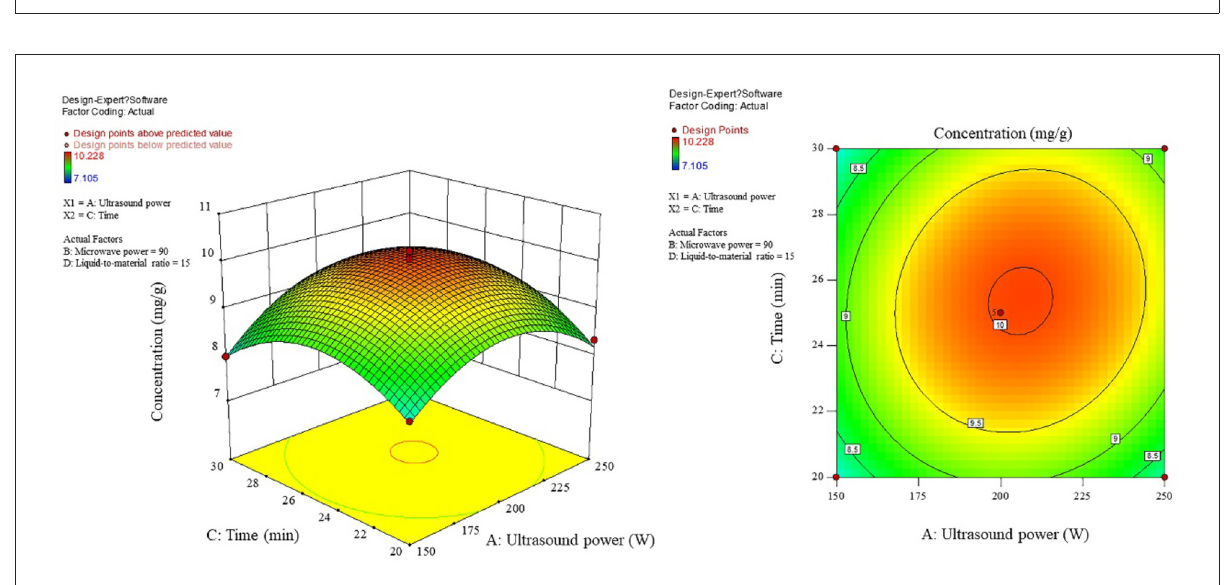
FIGURE4 Effect of ultrasound power and extraction time interaction on